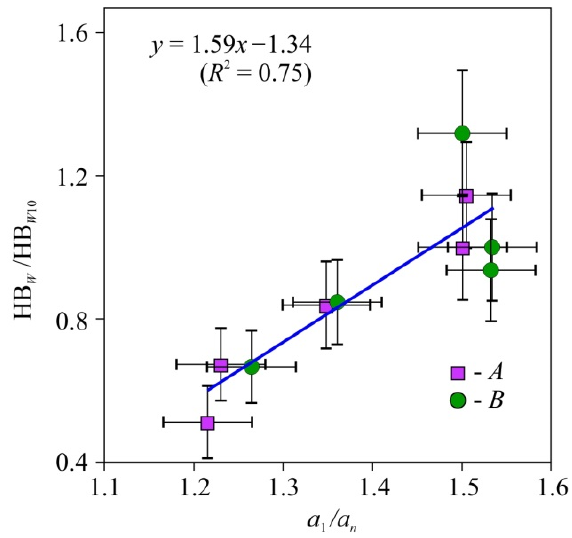
Figure 14. Dependence of the relative macrohardness HB W /HB W 10 of pine wood upon thermal diffusivity anisotropy— a 1 / a n . HB—Brinell hardness (12.7 mm sphere diameter, 1 mm indentation depth), a 1 , a n —thermal diffusivity coefficients along and across the fibers. HB W /HB W 10 is HB W values on radial (A) and tangential (B) faces, as shown in Figure 2, normalized to HB W at humidity W = 10% (HB W 10 ) [116].